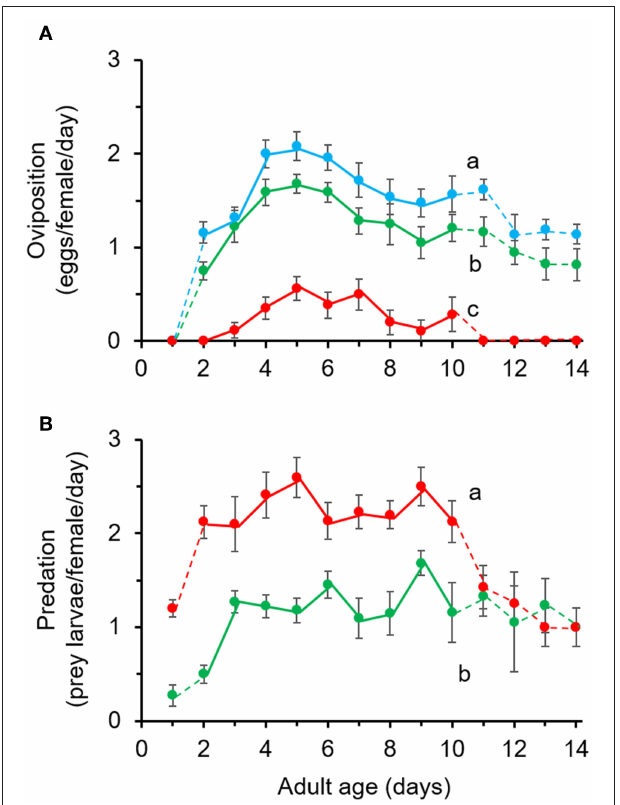
FIGURE 3 | Effects of pollen provisioning in a mixed diet with spider mites on the performance of adult Amblydromalus limonicus . Female adults ( n = 25 per treatment) were feeding on either Typha latifolia pollen (blue line, POL), spider mite larvae (red line, TUR), or a mixed diet consisting of spider mite larvae plus pollen (green line, MIX) for a period of 2 weeks. Shown are the mean ( ± SE) (A) number of eggs per female per day and (B) number of consumed prey (spider mite larvae) per female per day of young female A. limonicus from day 2 to day 10 of their adult life. Only data shown in full lines (day 2–10) were included in statistical analyses. Per panel, lines with different letters are significantly different (GLM followed by Bonferroni test, P < 0.001).